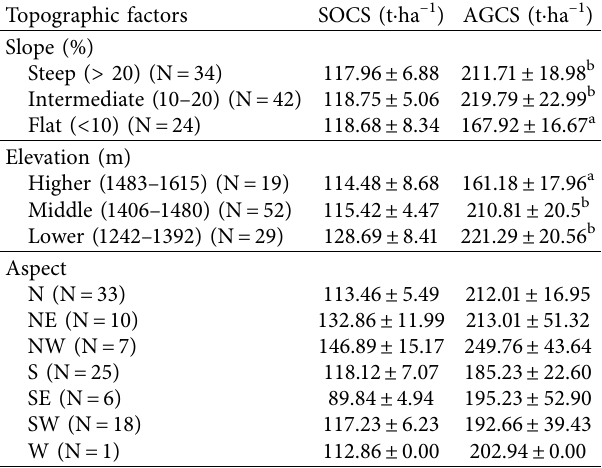
Table 3. The difference in mean AGCS (tha –1 ) between UF and DF does not show significance ( P > 0 . 05). The higher mean DBH value of the DF is related to the predominance of only higher DBH individuals in this forest (Table 3).